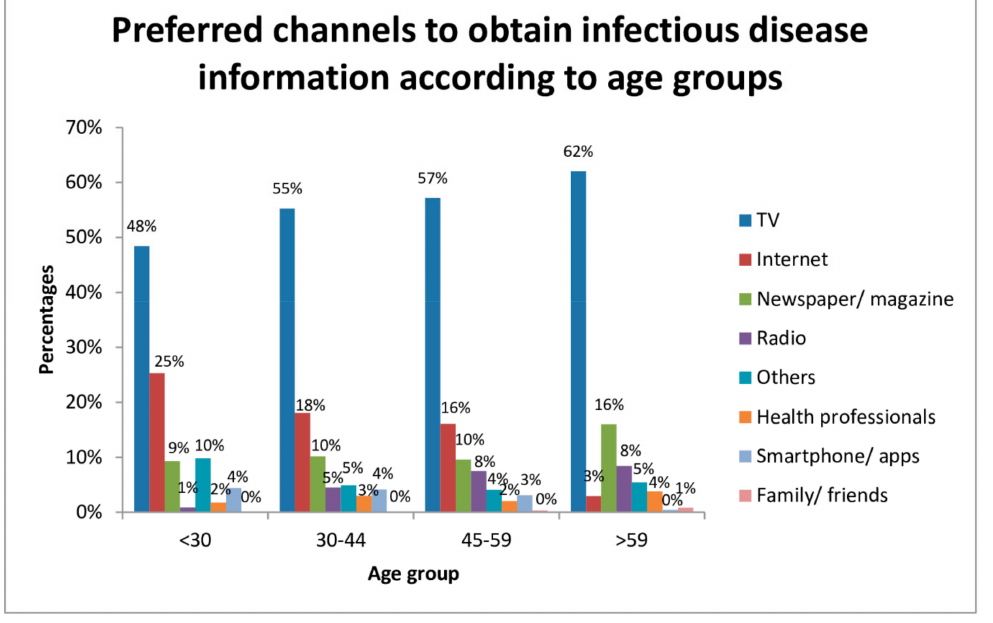
Figure 4. Preferred channels to obtain infectious disease information according to age